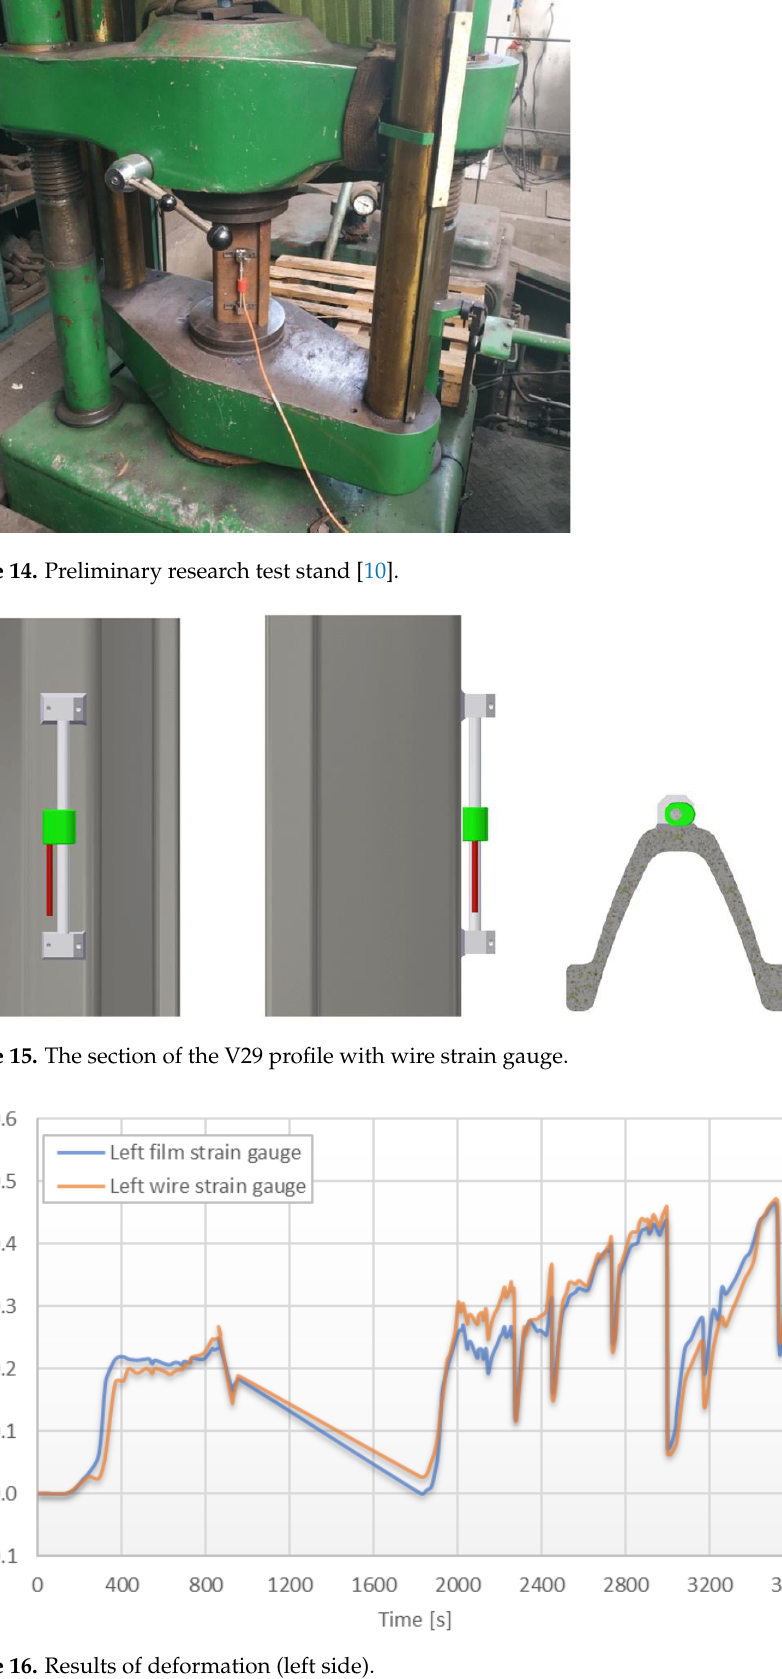
Figure 17. Results of deformation (right side). Based on the results of the research mentioned above, a comparative analysis of both measurement methods (i.e., the method of arch support deformation measurement using film strain gauges and vibrating wire strain gauges) was carried out using Spearman cor- relation and the Bland and Altman method [25]. Figures 18 and 19 show dispersion diagrams with a regression line for selected pairs of variables, i.e., arch support deformation (left and right side of arch) measured by film strain gauges and vibrating wire strain gauges, respectively.